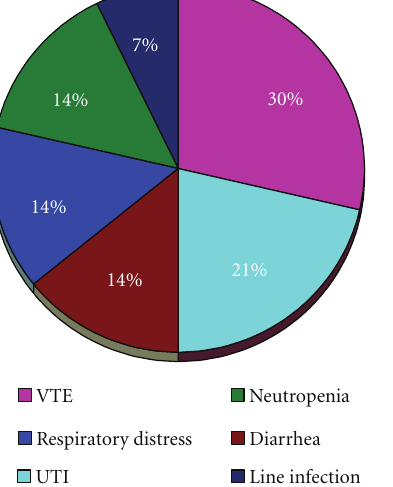
Figure 1: Grade 3 complications observed during the postoperative period in 34 patients treated with cytoreductive surgery and HIPEC with melphalan.